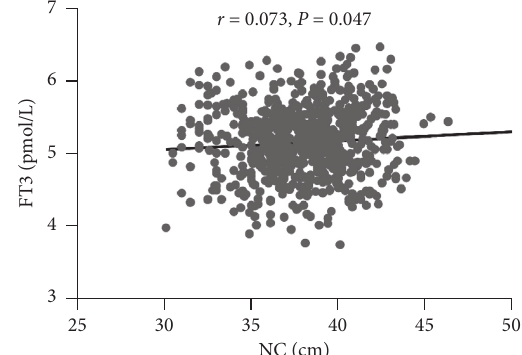
Figure 2: Spearman correlation analysis of neck circumference (NC) and free triiodothyronine